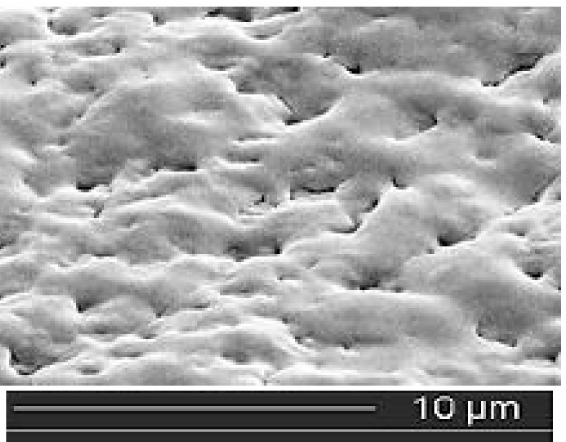
Figure 1. SEM micrograph of PNIPAM (cross-linked with 2% BIS) made in the presence of 5% sodium